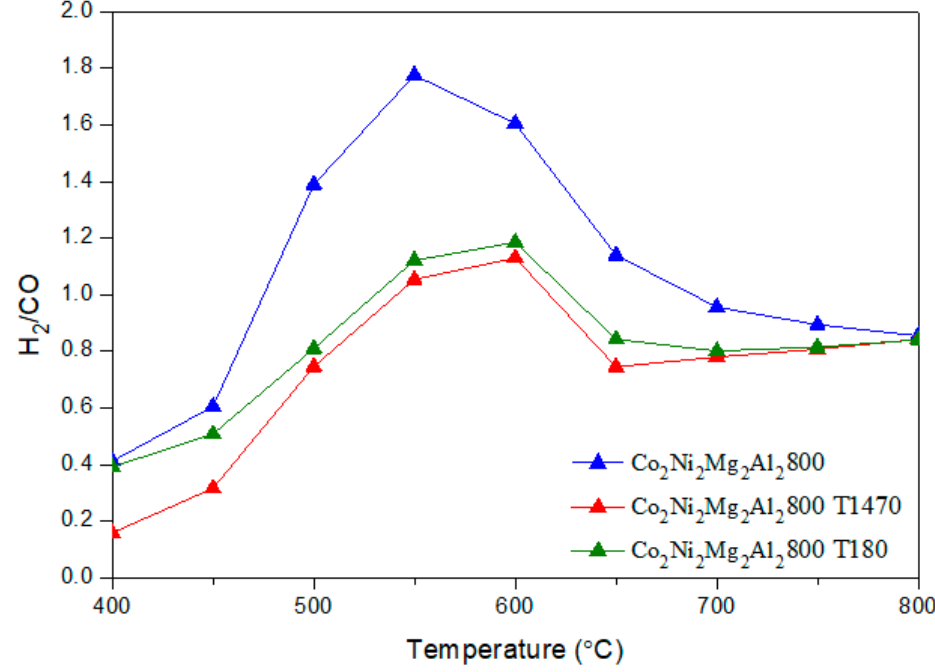
Figure 8. H 2 / CO molar ratio in DRM versus reaction temperature for the catalyst Co 2 Ni 2 Mg 2 Al 2 800 with and without toluene.